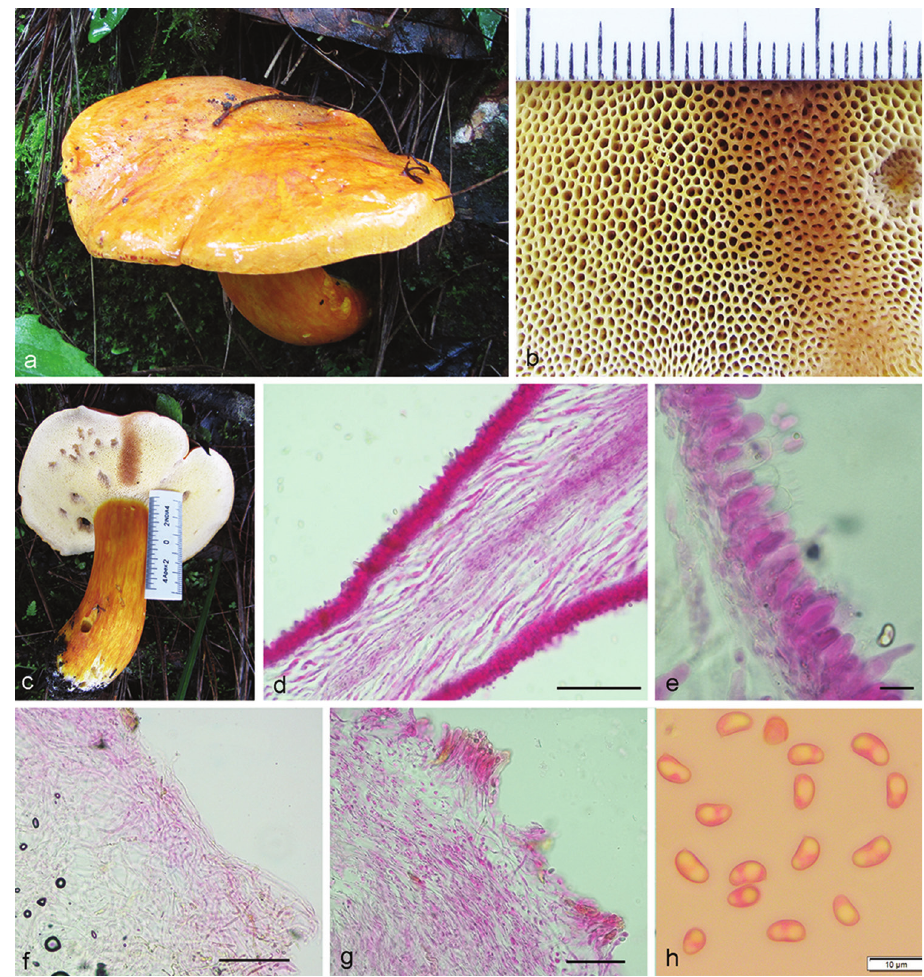
Figure 5. Tylopilus pseudoballoui (DC 17-30, holotype). a, c Fresh basidiomata in the field b Pore surface after bruising d Hymenophoral trama e Pleurocystidia f Pileipellis g Stipitipellis h Basidiospores. Scale bars: 100 µm ( d, f ); 50 µm ( g ); 10 mm ( e, h